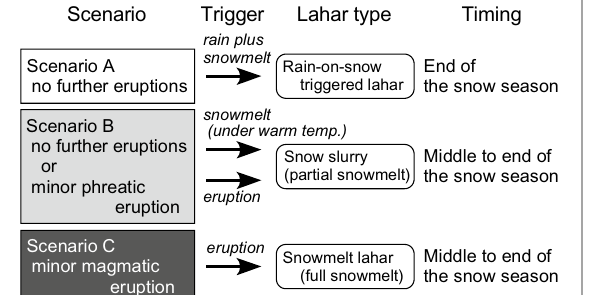
Table 2 Input parameters for each